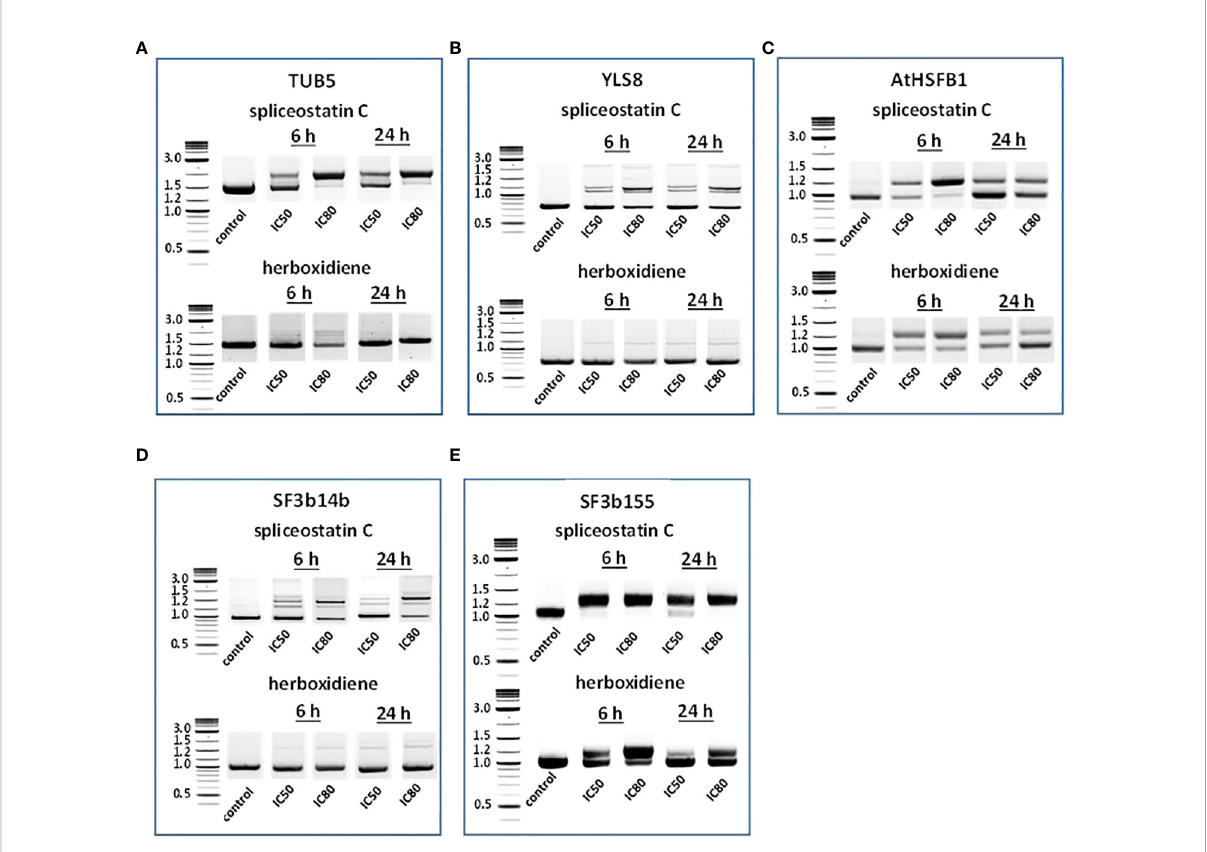
FIGURE 3 Detection of splicing activities by RT-sqPCR. The results demonstrate the maturation of precursor mRNA of selected genes affected by inhibitors leading to intron retention, alternative 5 ’ or 3 ’ side splicing (A – E) . TUB5 (A) ; YLS8 (B) ; AtHSFB1 (C) ; SF3b14b PHF5-like protein (D) and SF3b155 (E)